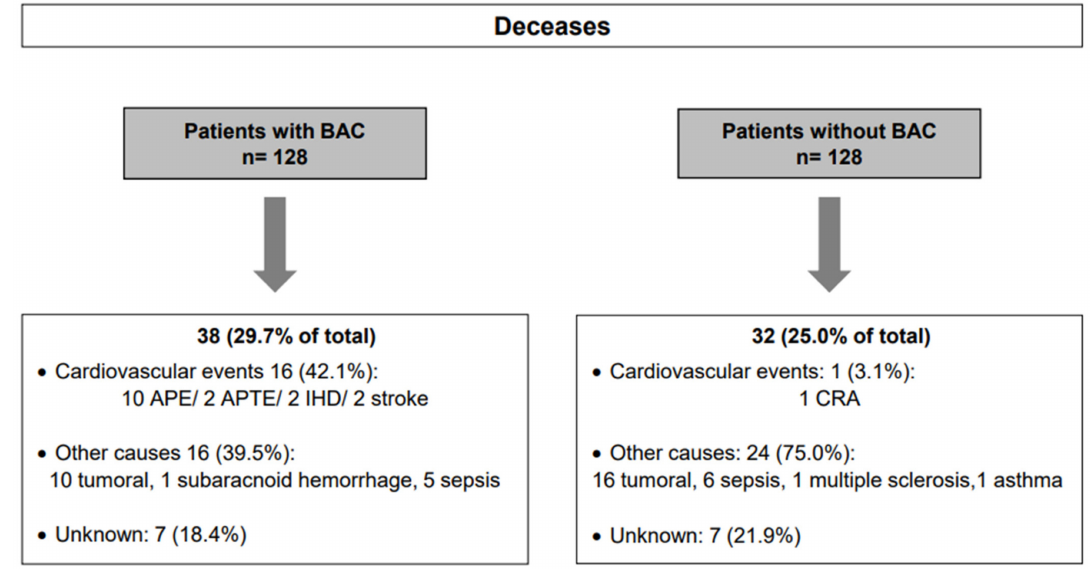
Figure 3. Overview of deceases and causes in patients with or without BAC. BAC: Breast arterial cal- cification, APE: Acute pulmonary edema; APTE: Acute pulmonary thromboembolism; IHD: Ischemic heart disease; CRA: Cardiorespiratory arrest.